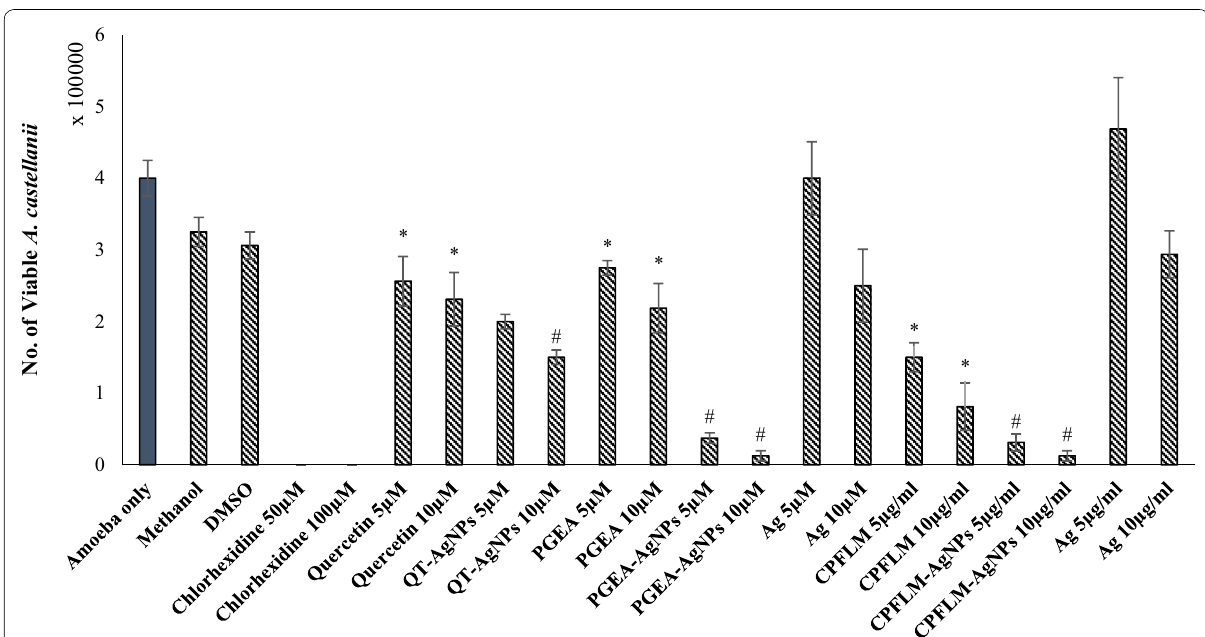
Fig. 3 Amoebicidal effects of QT, PGEA, CPFLM and the nanoconjugates of the natural compounds above mentioned against A. castellanii . 5 A. castellanii was incubated with 5 and 10 μM (or mg/mL) of the natural compounds and the nanoconjugates for 24 h at 30 ° C then the viability of A. castellanii was determined by staining with 0.1% Trypan Blue. The natural products QT, PGEA and CPFLM showed significant inhibition of A. castellanii growth when compared to the negative control (amoeba alone) (*P < 0.05, using two sample T-test, two-tailed distribution). Nanoparticles conjugation enhanced the antimaoebic activity of natural products as compared to AgNPs and compounds alone (*P < 0.05, using two sample T-test, two-tailed distribution). #shows significance as compared to compound and AgNPs